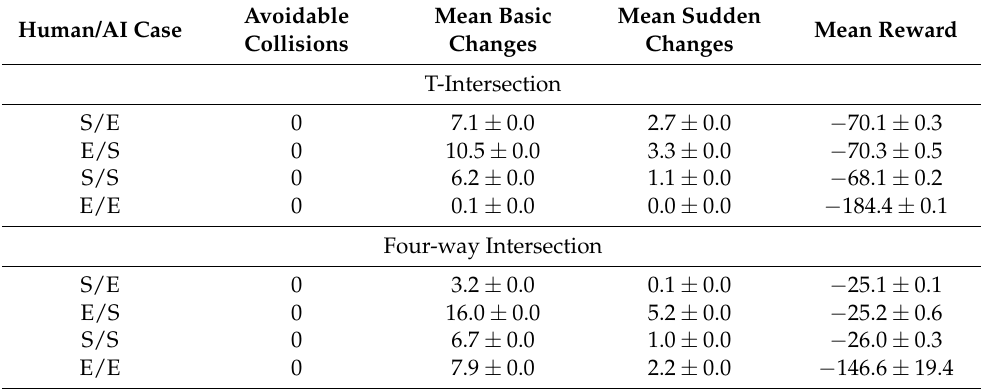
Table 14. Human: noisy light, AI: sensor and mask. Test results for manager performance and behavior. Human/AI Case